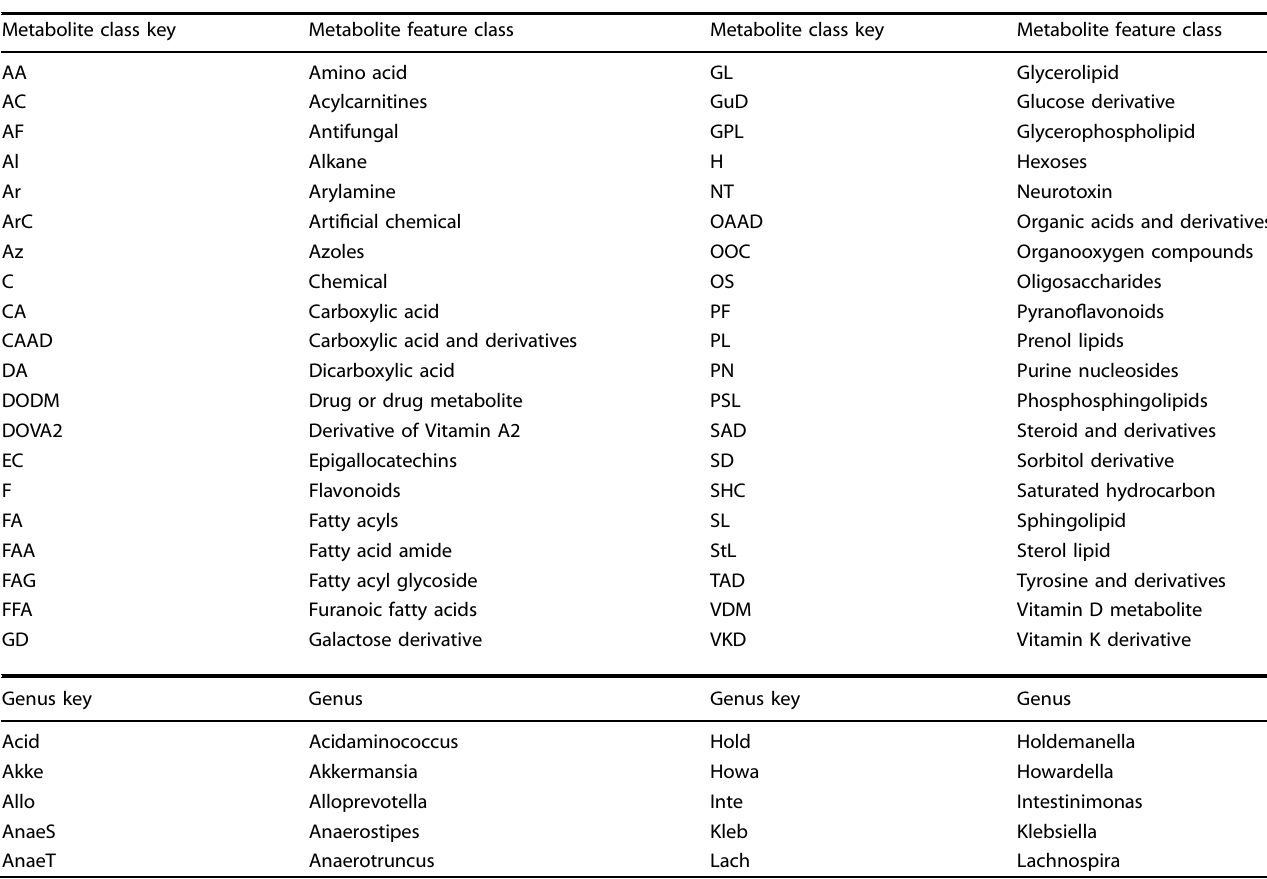
Table 6. Key to Figures 1 and